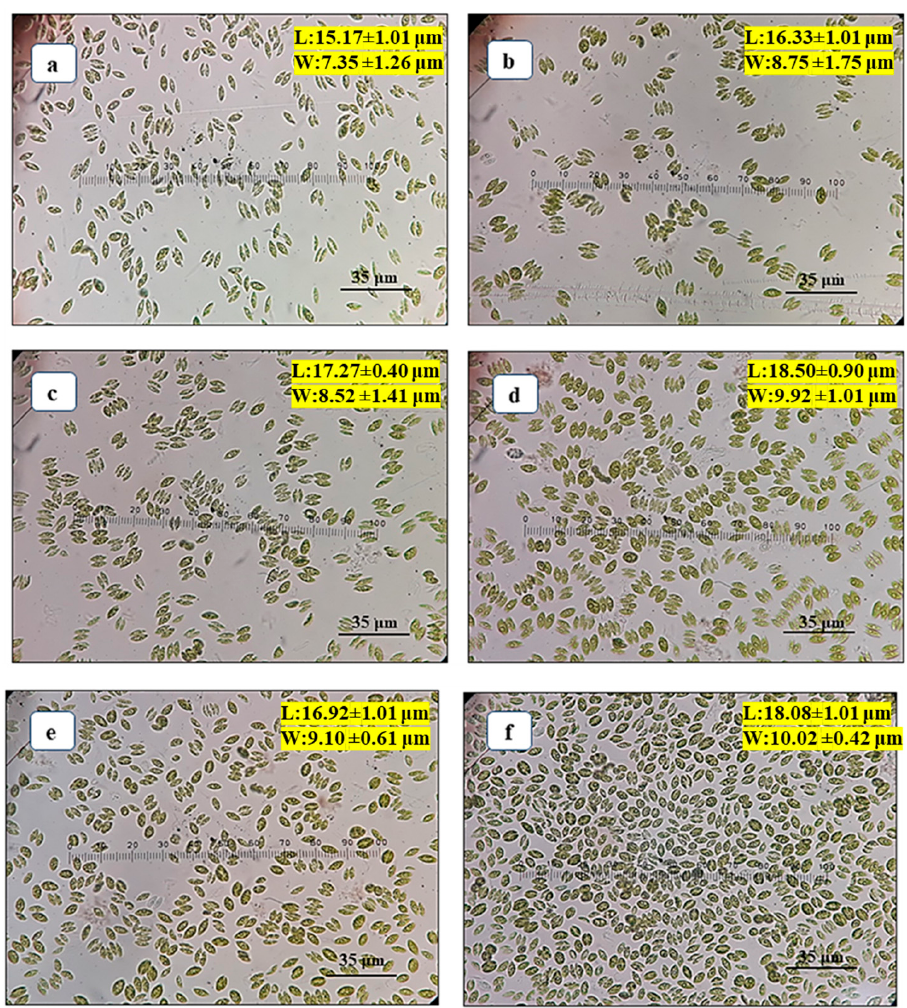
Figure 1. Morphological variation of Scenedesmus rotundus -MG910488 grown in the different growth media was observed ( a ) BBM ( b ) CHU-10 ( c ) Fogg’s ( d ) BG-11 ( e ) CFTRI and ( f ) ZM. L; length, W; width.